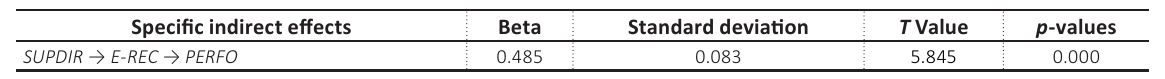
Table 5. Specific indirect effects